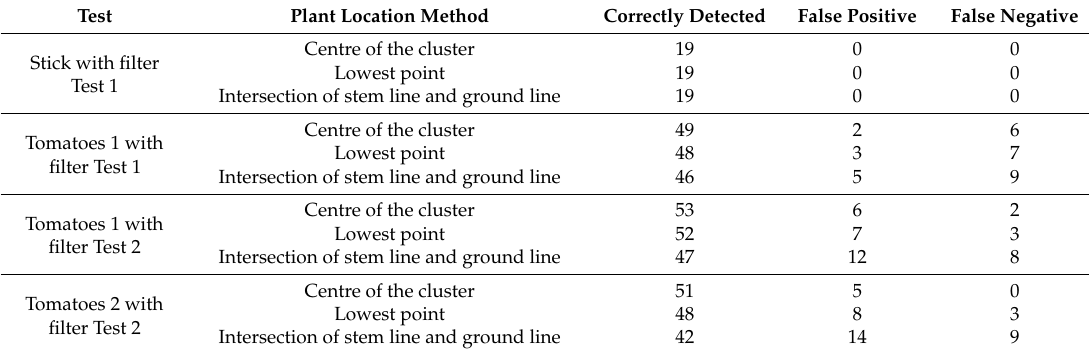
Table 8. Plant and sticks detection results.